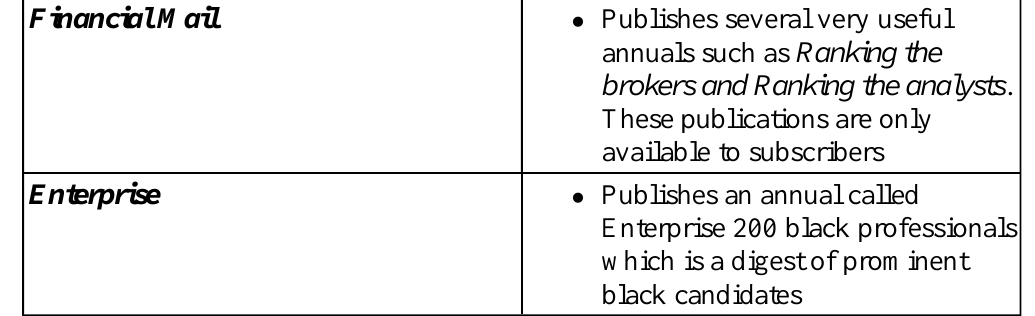
Table 1 Examples publications that contain names of award winners Financial